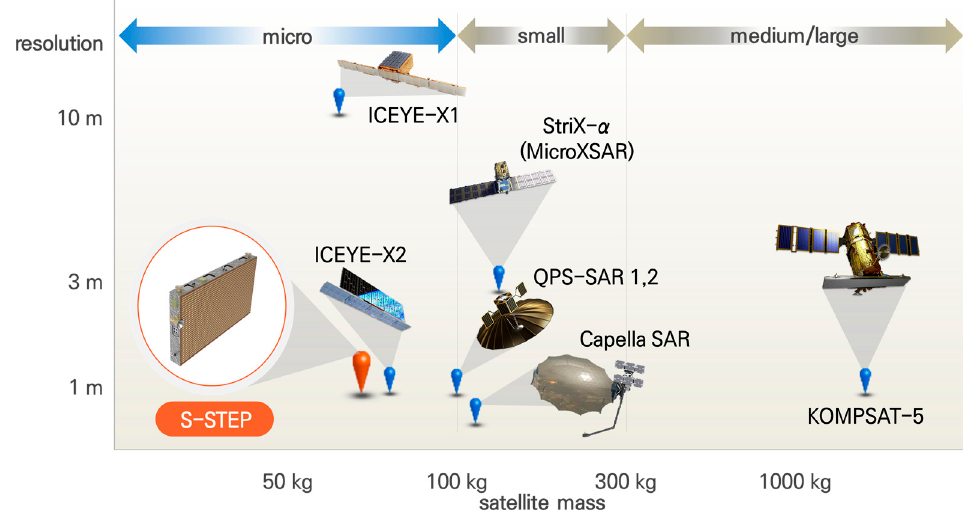
Figure 1. Comparison of satellite masses vs. SAR image resolutions.